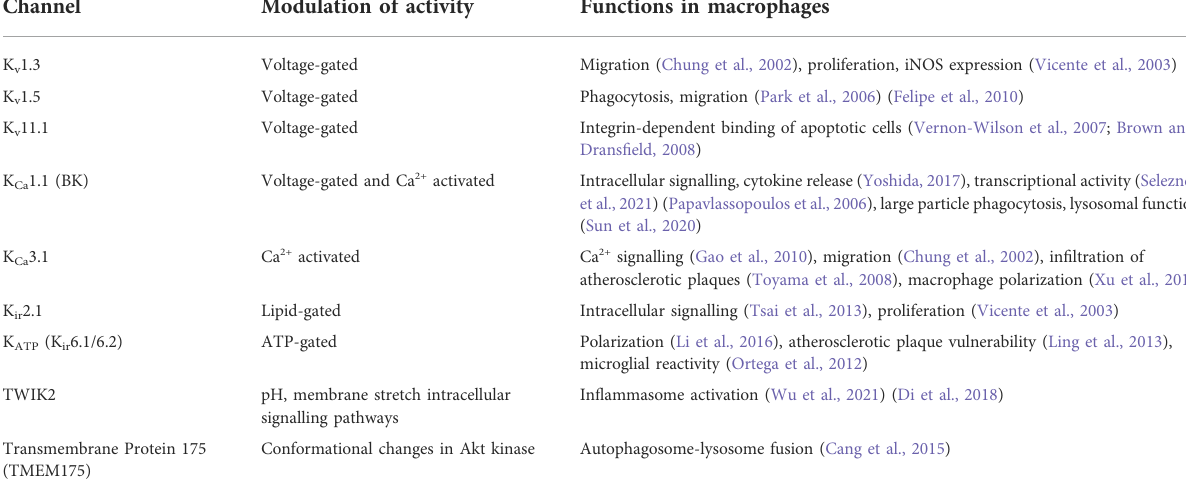
TABLE 2 A summary of potassium (K + ) ion channels identi fi ed in macrophages to date.